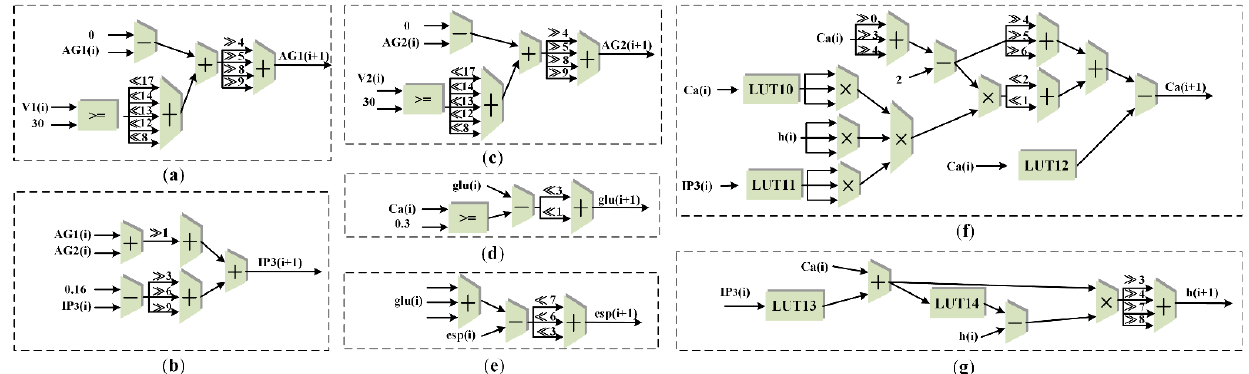
Figure 10. Tripartite synapse variable pipeline calculation structure, containing ( a , c ) 2 ‐ AG pipeline, ( b ) IP3 pipeline, ( d ) glu pipeline, ( e ) esp pipeline, ( f ) Ca pipeline, and ( g ) h pipeline. V1(i) and V2(i) are the membrane potentials of PD and LP neurons at time i, respectively.